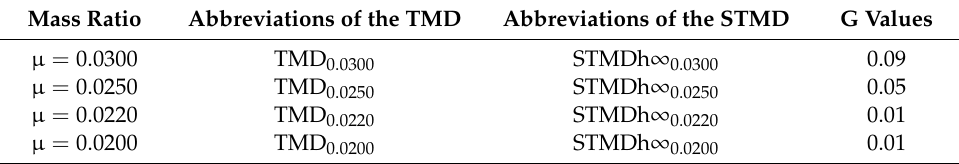
Figure 4. The Excitation-1 and the Excitation-2 forces, acceleration (left), and frequency changes (right). Table 1. Different mass ratios for the tuned mass damper (TMD) and the STMDh∞.